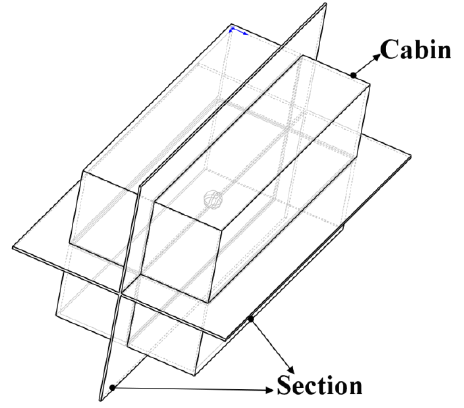
Figure 1. Cross-section through the center of the cabin.